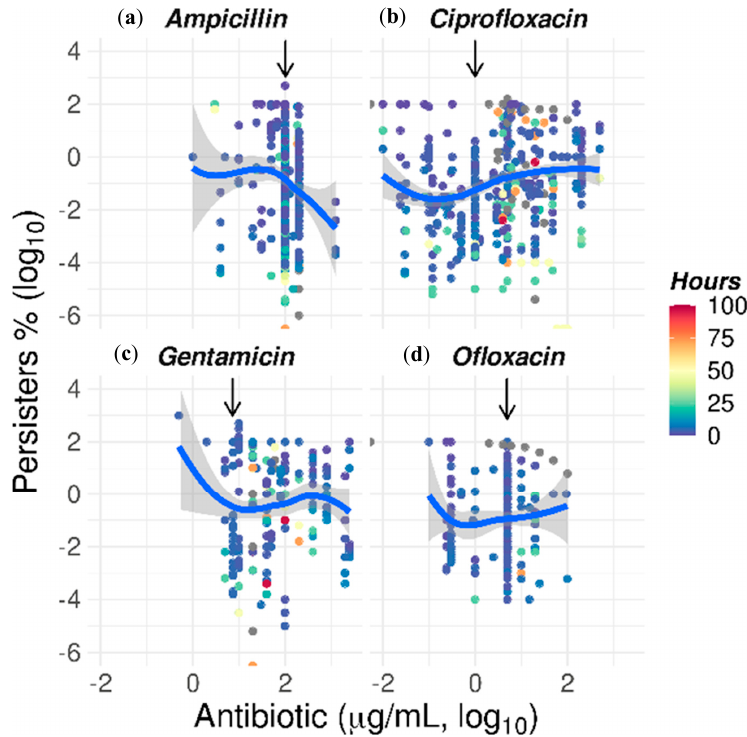
Figure 9. E ff ect of antibiotic concentrations on the levels of bacteria persistent to antibiotics: The concentration of antibiotic is represented as the log 10 of µ g / mL along the abscissa of each plot. The incidence of persister cells is represented also as the log 10 of the percentage of cells growing in solid media after exposure to antibiotics in comparison to the number of cells at time zero. The number of persisters against time were fitted by local polynomial regression fitting by weighted least squares as detailed in the materials and methods. The incubation times for any given concentrations of antibiotic were also plotted with a color spectrum of blue to red for up to 100 h. The arrows point at the most frequently used concentration for each antibiotic (mode of antibiotic usage in Table